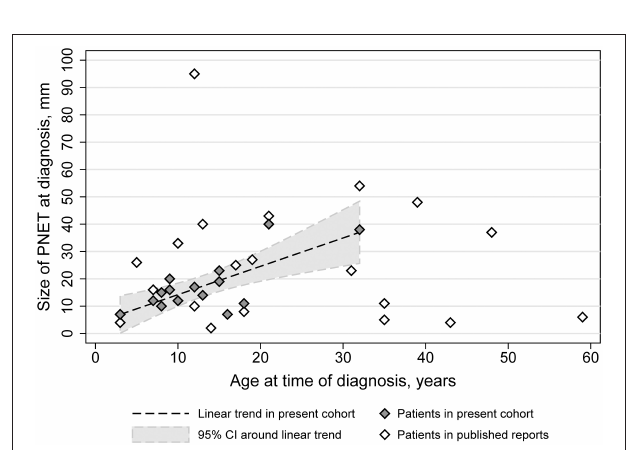
FIGURE 4 | PNET diameter as a function of age in TSC subjects of the TS Alliance’s Natural History Database, the Cincinnati Children’s Hospital TSC Database, and previously published